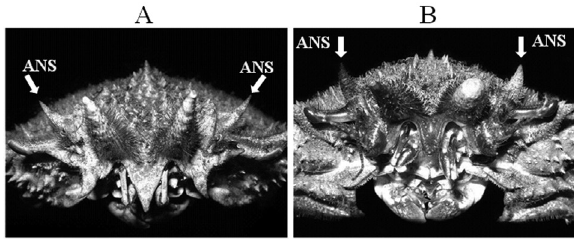
Fig . 2. – Shape and orientation of the antorbital spines (frontal view). Maja squinado (A); M. brachydactyla (B). Antorbital spines